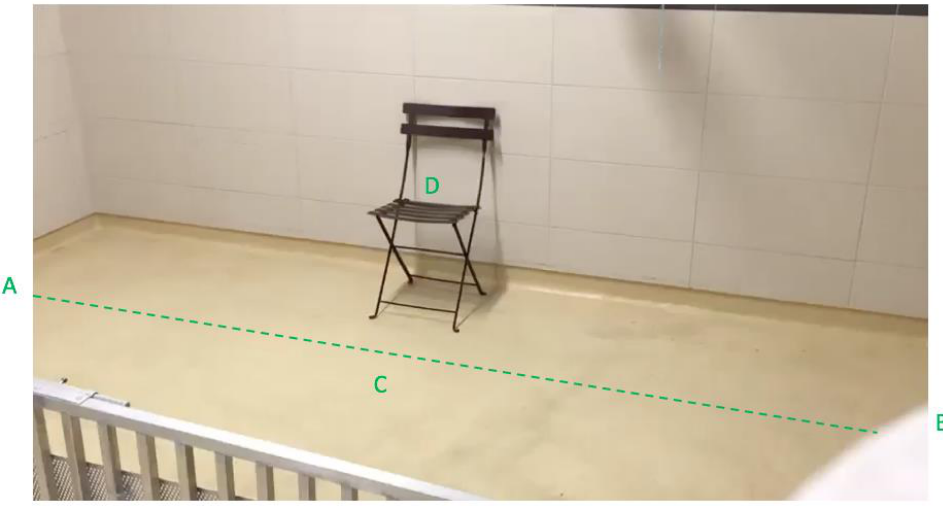
Figure 1. Experimental setup. A and B: Predefined line to be walked by the experimenter during Human Move condition. C and D: Experimenter locations for the Human Still condition (respectively for the Standing Still part and the Sitting Still part).